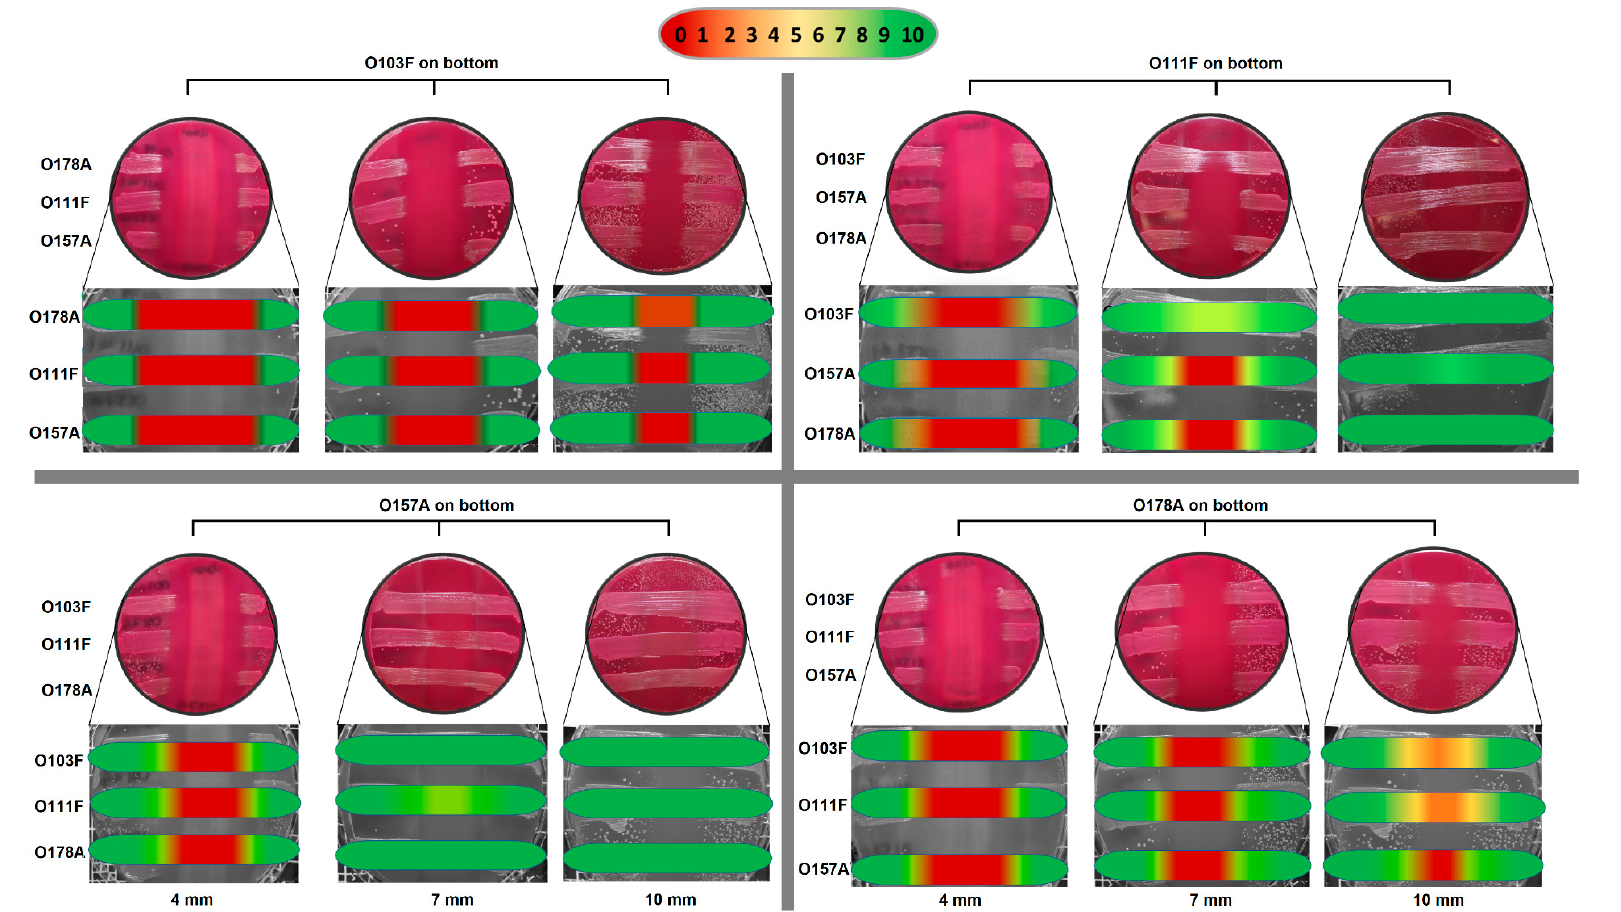
Figure 5. Omelette method results for Escherichia coli O103F, O111F, O157A, and O178A with varying plate thickness (4, 7, and 10 mm) against each other examining zones of no growth. Growth zones are graded beneath each plate with red (0) representing no growth to green (10) representing no inhibition of growth.